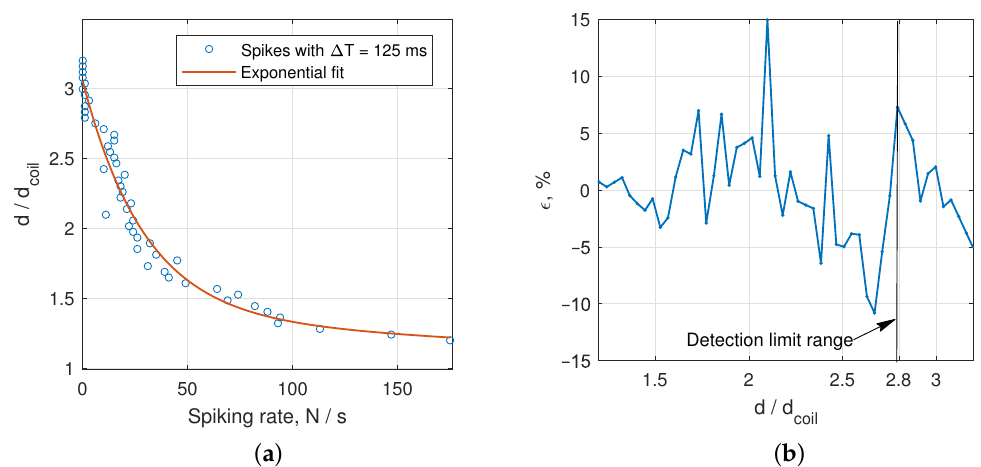
Figure 21. Determination of the distance to the brass plate on the count of interspike intervals with ∆ T = 125 ms : ( a ) experimental data curve fitting; and ( b ) distance detection error relative to the limit distance d = 2.8 ∅ . Obtained approximation may be used for practical distance measurements. Table 1. Detection distances for plates of different metals and sizes. All dimensions are in cm. Plate Size Steel Brass Aluminum 25 × 25